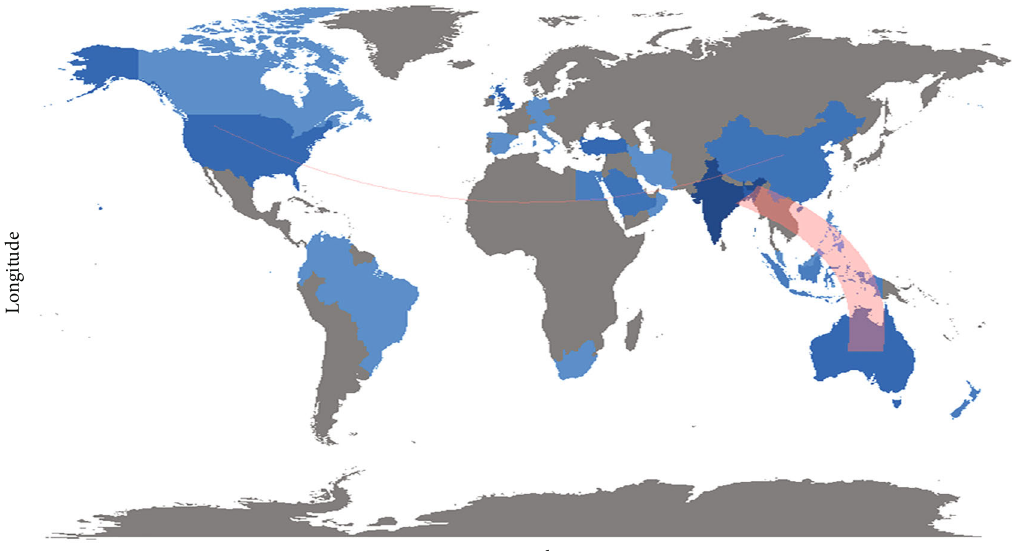
Figure 2: Collaboration world